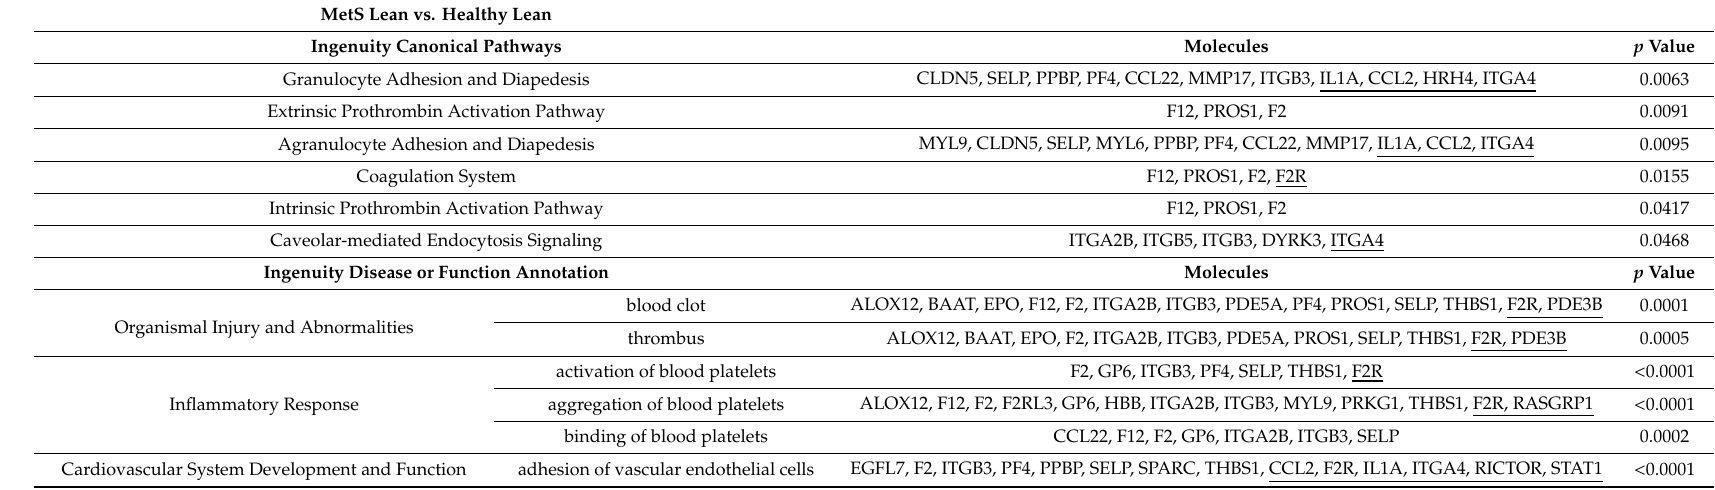
Table 4. Enrichment in Ingenuity Canonical Pathways and Diseases or Functions Annotations among genes di ff erentially expressed between MetS lean and healthy lean individuals, where the majority of genes within each pathway are up-regulated. Down-regulated genes are